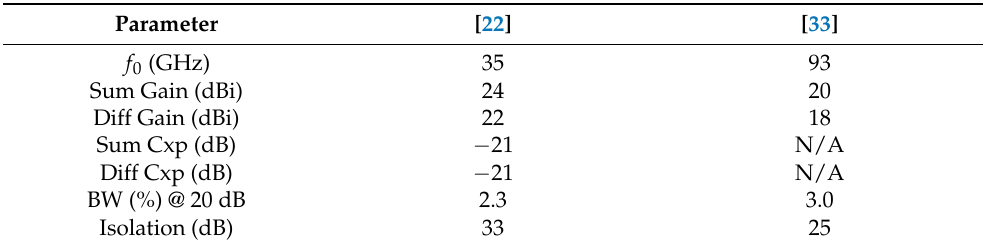
Table 1. Comparison of triple-radiation pattern monopulse antennas by high-precision subtractive